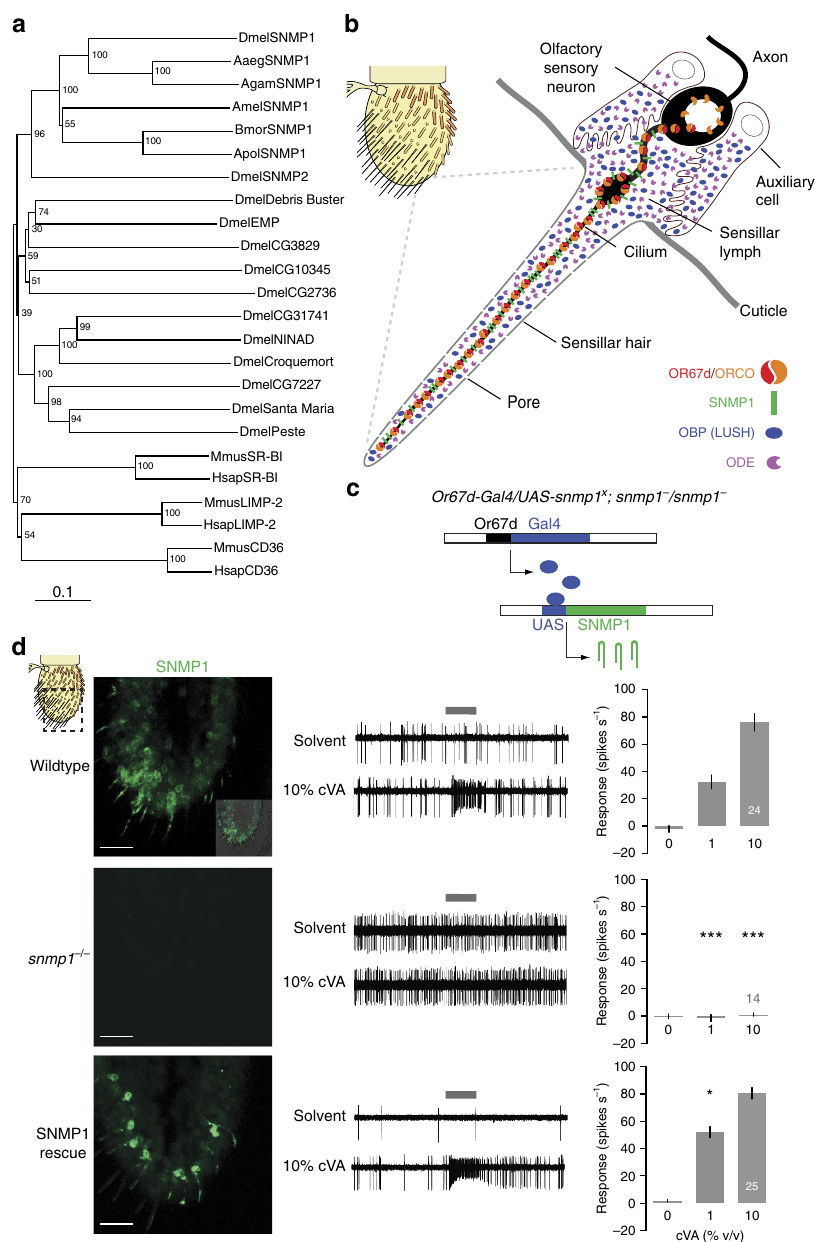
Figure 1 | An in vivo transgenic system for structure–function dissection of SNMP1. ( a ) Neighbour-joining tree of insect SNMP1 orthologues, and other Drosophila and mammalian CD36-related proteins (Dmel, Drosophila melanogaster ; Aaeg, Aedes aegypti ; Agam, Anopheles gambiae ; Amel, Apis mellifera ; Bmor, Bombyx mori ; Apol, Antheraea polyphemus ; Mmus, Mus musculus ; Hsap, Homo sapiens ). The tree was built with MEGA5 (ref. 68); bootstrap support (1,000 replicates) is indicated. The scale bar units show amino-acid substitutions per site. ( b ) Schematic representation of the D. melanogaster antenna and a detail of a pheromone-sensing trichoid sensillum. The cVA receptor, OR67d, requires an essential co-receptor (ORCO) 16,17 . Sensillar lymph contains the OBP LUSH 40 and odorant-degrading enzymes (ODEs) 69 . ( c ) Schematic representation of the in vivo transgenic expression system. The GAL4/UAS system was used to drive the expression of wild-type or mutant versions of SNMP1 (SNMP1 X ), or other CD36-related proteins, in OR67d-expressing neurons in an snmp1 null mutant background. ( d ) Analysis of wild-type ( w 1118 ), snmp1 homozygous mutant ( snmp1 1 /snmp1 2 ) and SNMP1 rescue ( Or67d-GAL4/UAS-snmp1;snmp1 1 /snmp1 2 ) flies. Left: immunostaining with a -SNMP1 on antennal cryosections. The approximate area shown is indicated with a dashed black square in the antennal cartoon at the top left. An inset in the wild-type immunostaining illustrates the morphological landmarks by the overlay of fluorescence and bright-field images. Scale bars, 20 m m. Centre: representative traces of electrophysiological recordings of OR67d neurons in male flies stimulated with solvent (paraffin oil) or 10% cVA. The grey bar indicates the stimulus time (1s) in this and all subsequent figures. Right: mean neuronal responses ± s.e.m. to the indicated stimuli (see also Supplementary Table 1). As n is equal for all concentrations tested for each genotype, it is shown in white or grey within or above only the 10% cVA stimulus bar, in this and all subsequent figures. There are significant statistical differences in neuronal responses due to genotype for both 1 and 10% cVA (Kruskal–Wallis, P o 0.0001). Significant differences in cVA responses for the different genotypes compared with wild-type ( w 1118 ) are indicated in the figure; * P o 0.05, *** P o